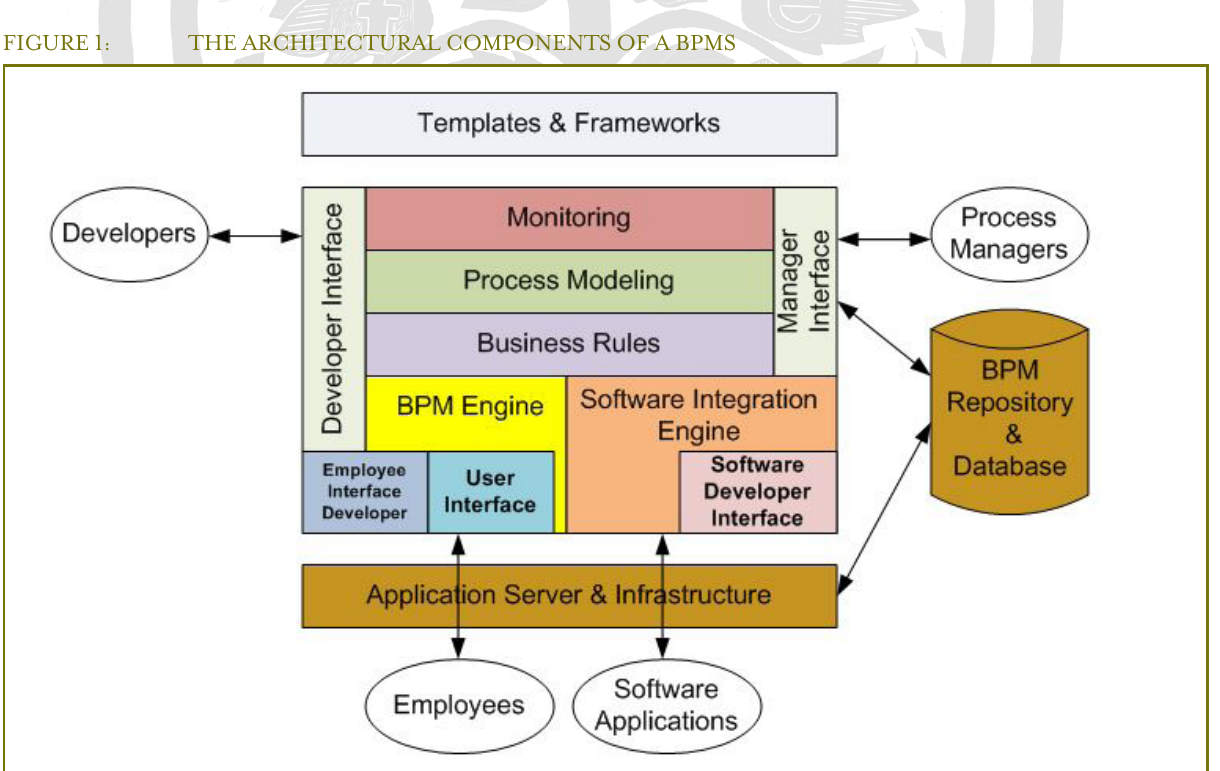
THE ARCHITECTURAL COMPONENTS OF A BPMS